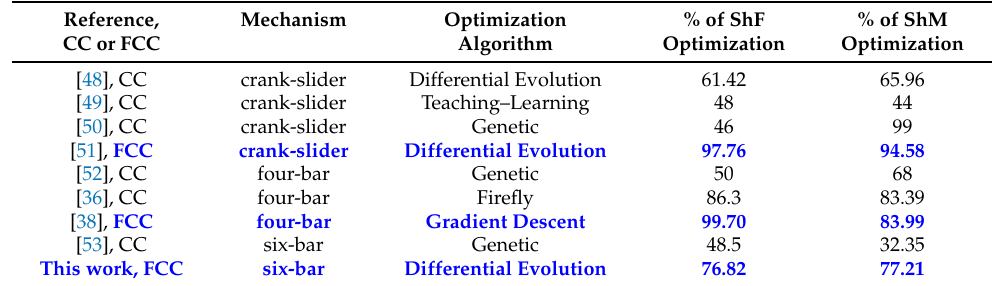
Table 4. Comparison of balancing results for several types of mechanisms and optimization